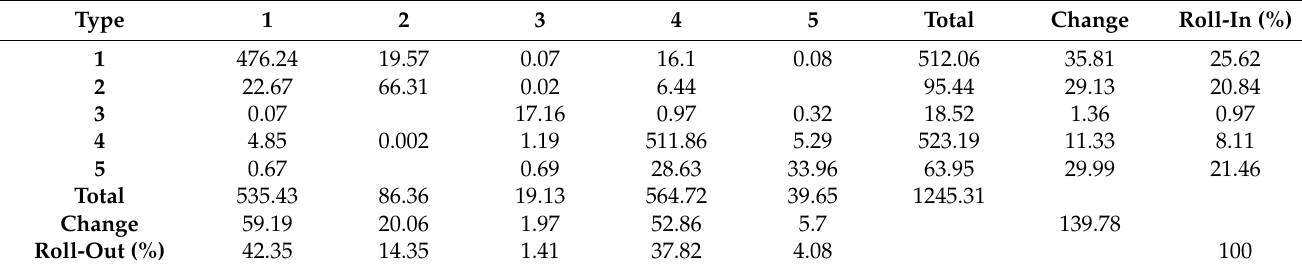
Figure 4. Spatial changes in ecosystems in Mianzhu City from 2005 to 2018. Note: The legend numbers represent each type in the ecosystem. Among them, 1–5 represent forest, grassland, wetland, farmland and urban. Each legend number represents a change in the type from left to right. For example, the number 12 represents the change from forest to grassland. Table 4. The transfer matrix of ecosystem types in Mianzhu city from 2000 to 2018(Km 2 ).